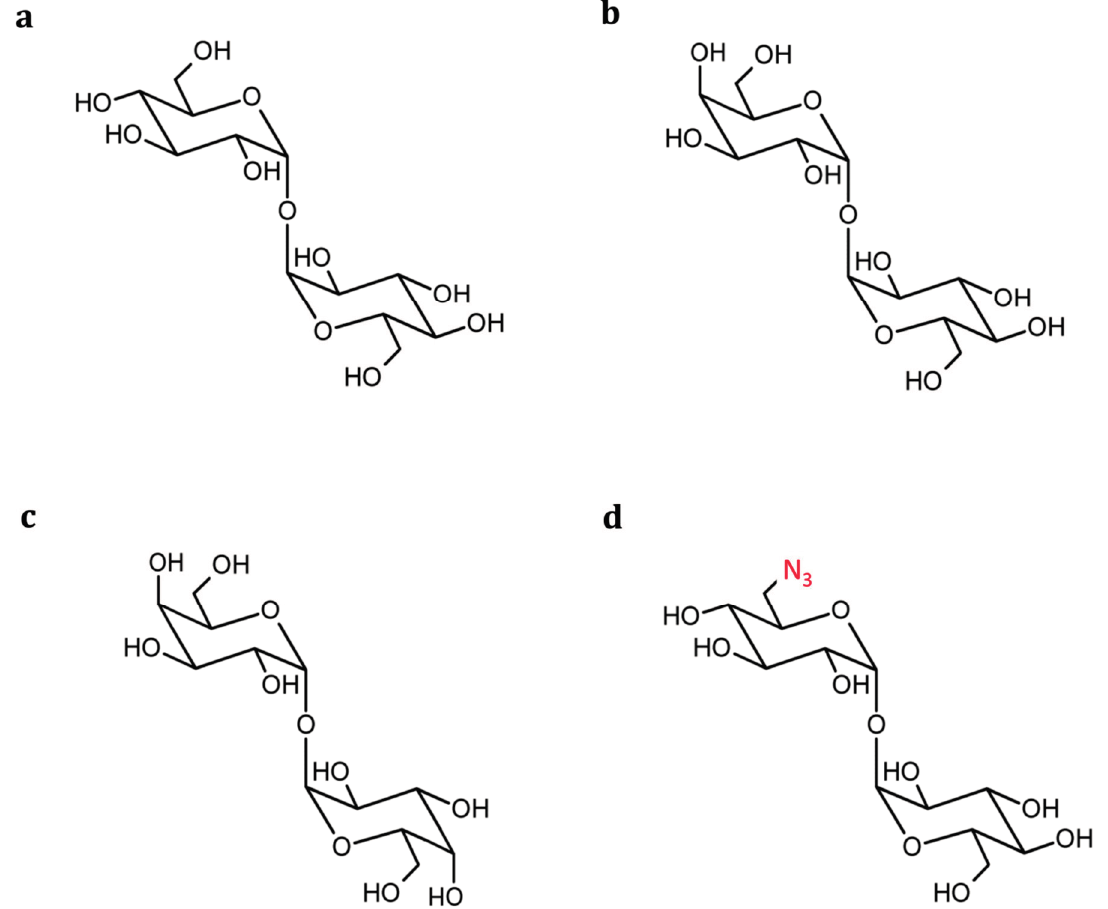
Figure 1. Structure of trehalose ( a ) and its analogues lactotrehalose ( b ); galactotrehalose ( c ); and 6-azidotrehalose ( d ). The azide-functional group is indicated in